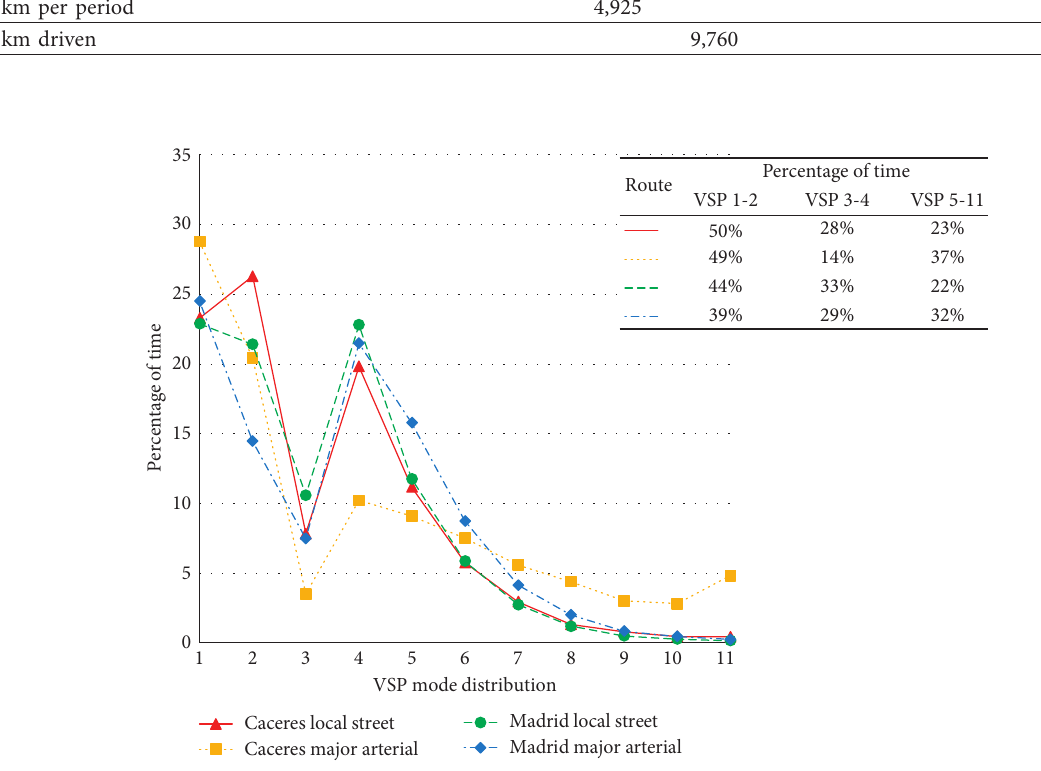
Figure 5: VSP mode distribution for different types of road and